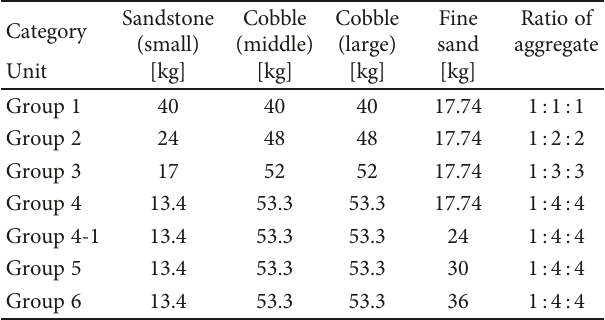
Table 2: The ratio condition of experimental